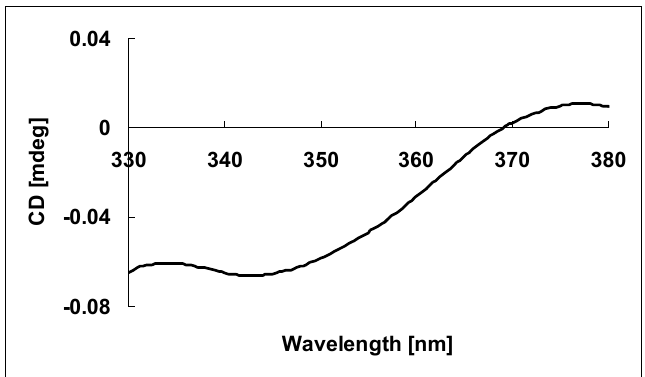
Figure 4. CD spectrum of Rh-complex of 1 with the inherent CD spectrum subtracted.